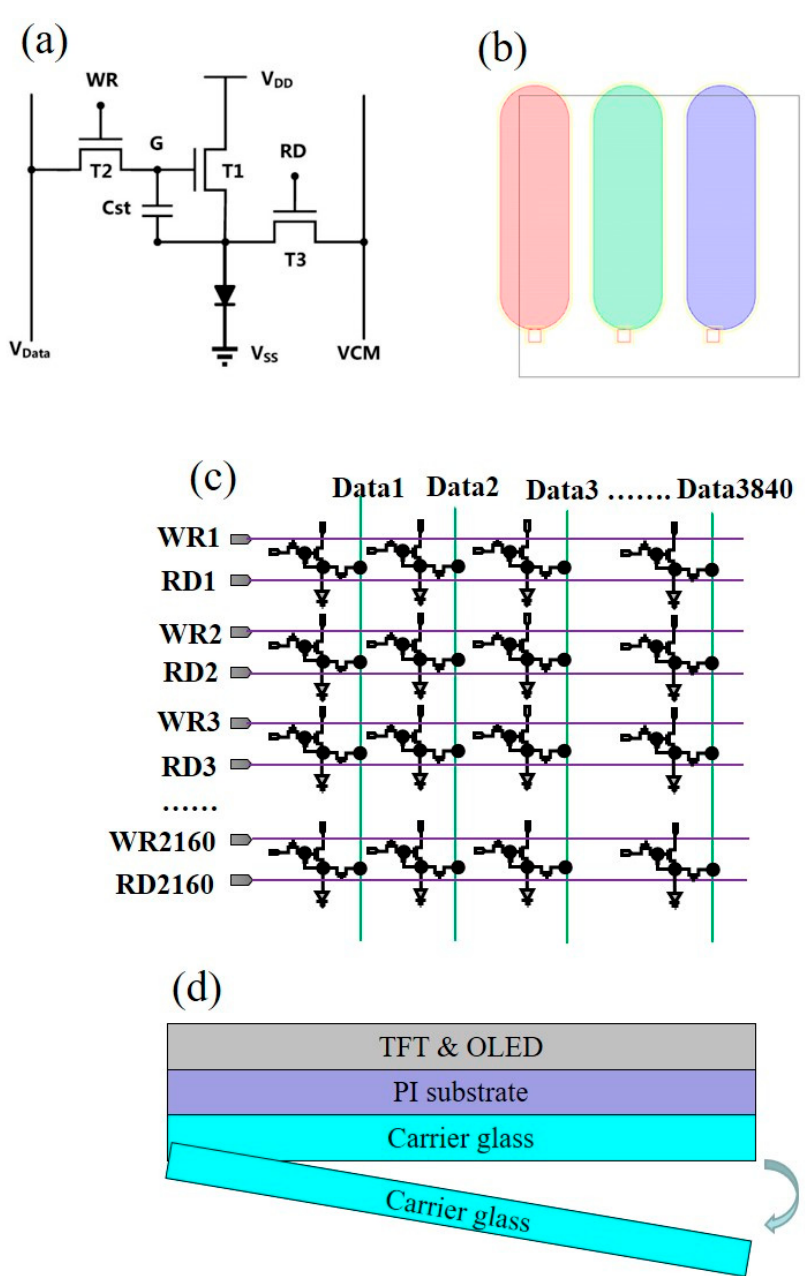
Figure 7. The 31-inch 4K AMOLED flexible display. ( a ) The circuit design of each sub-pixel in the display; ( b ) the sub-pixel arrangement in each pixel; ( c ) the TFT array diagram of 4K AMOLED display; and ( d ) the schematic diagram of thin films on the backplane.